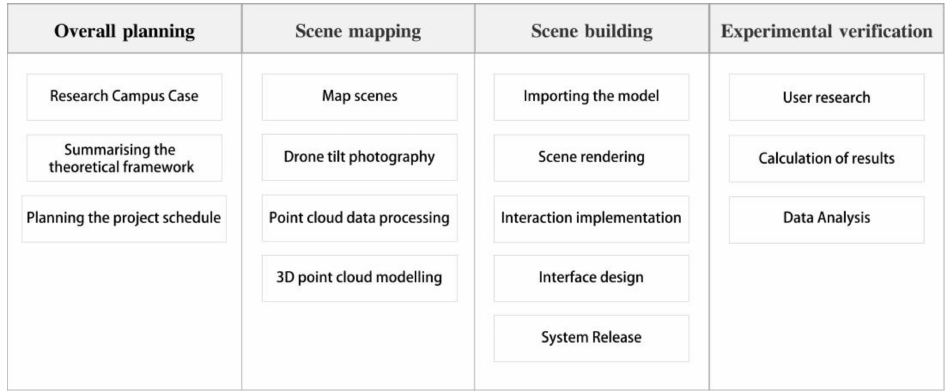
Figure 1. Structure of the overall